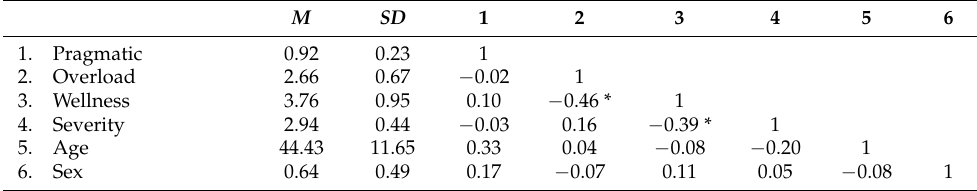
Table 1. Descriptive statistics and correlation analysis.